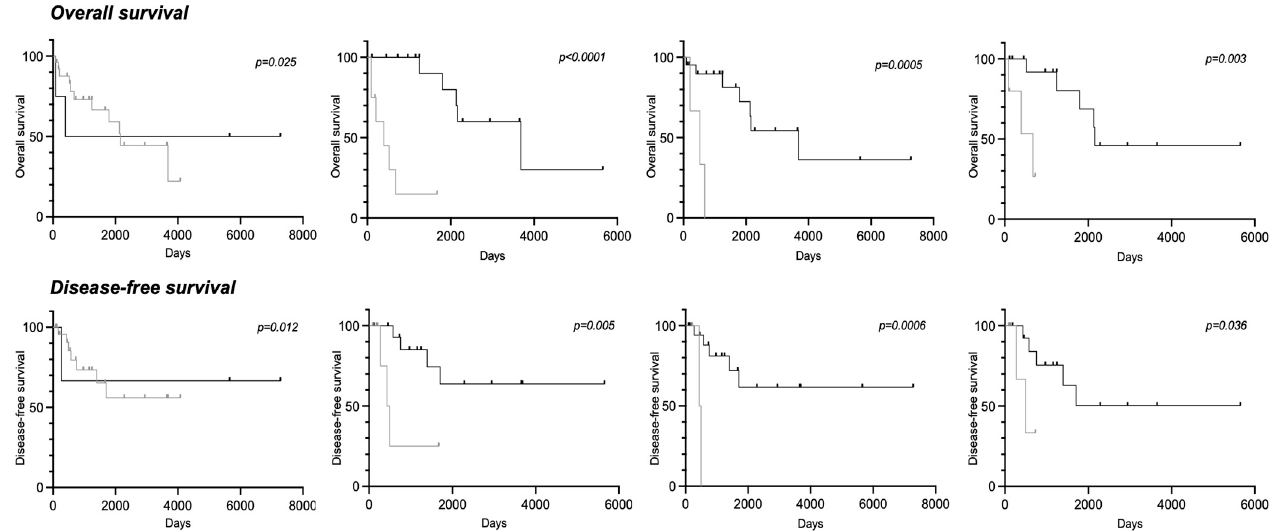
Figure 2. Correlations between RANKL/CD163/CD68/CD4 + expression and patient outcomes. Kaplan–Meier curves showing the association between the expression of the biomarkers with overall survival and disease-free survival.